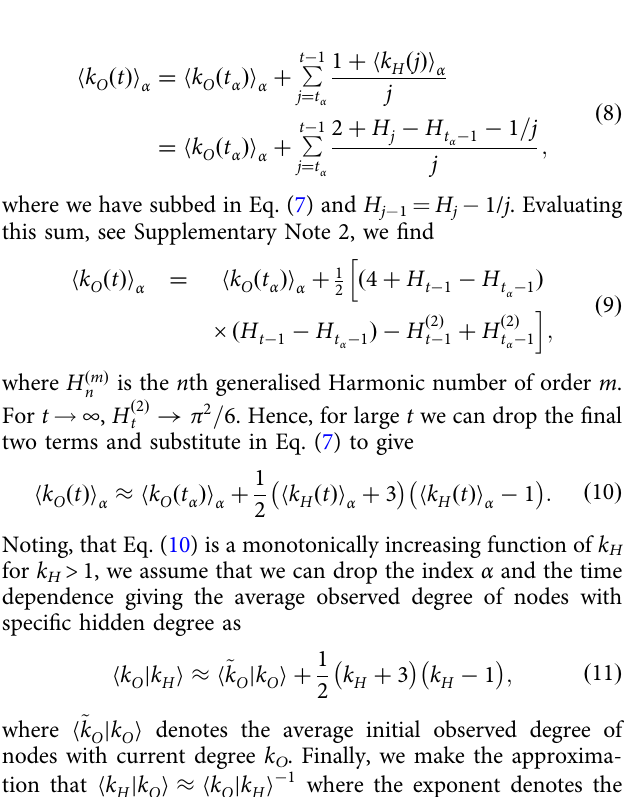
Fig. 2. The approximation for the cumulative degree distribution stems from the observation that, on average, nodes with k 0 > k were added to the network at t 0 < t α , whereas nodes with k 0 < k were added to the network at t 0 > t α . Note that Eq. (18) is close to the scaling expected from sub-linear preferential attachment 40 with an exponent 1/2.